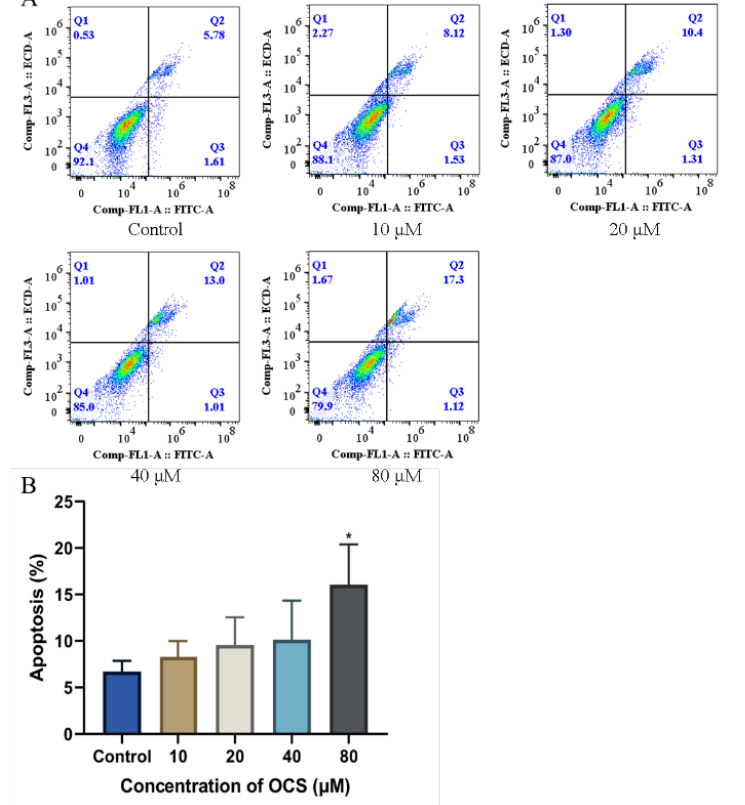
Figure 6. Induction of apoptosis by OCS in HepG2 cells after 24 h exposure. ( A ) Apoptosis in HepG2 cells after treatment with OCS for 24 h was assessed by Annexin-FITC/PI staining. ( B ) Percent of apoptotic HepG2 cells induced by OCS following 24 h treatment. Values are mean ± SD of three independent experiments ( n = 3) (* p < 0.05 vs. control).